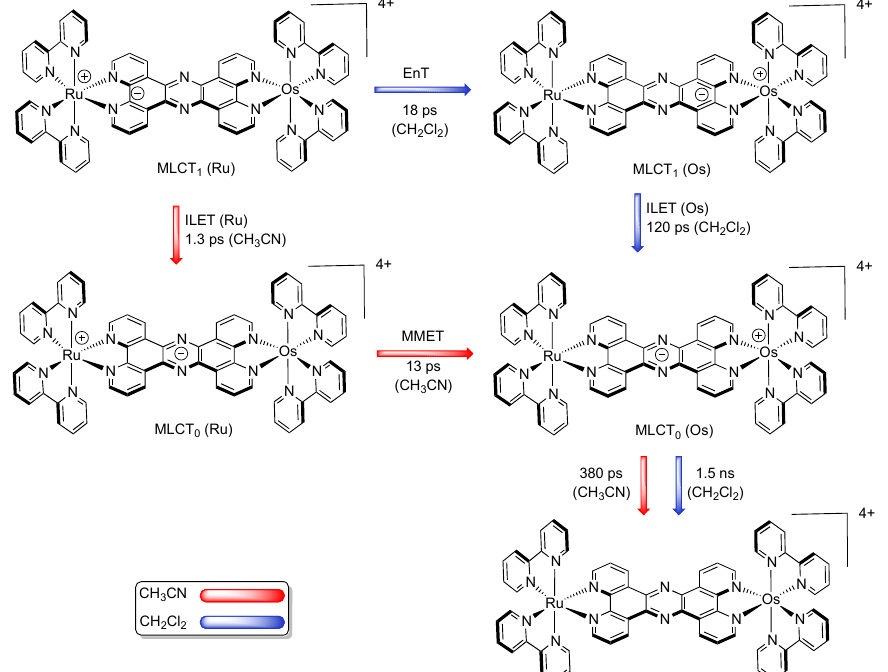
Cl (blue) and CH CN (red) 2 2 3